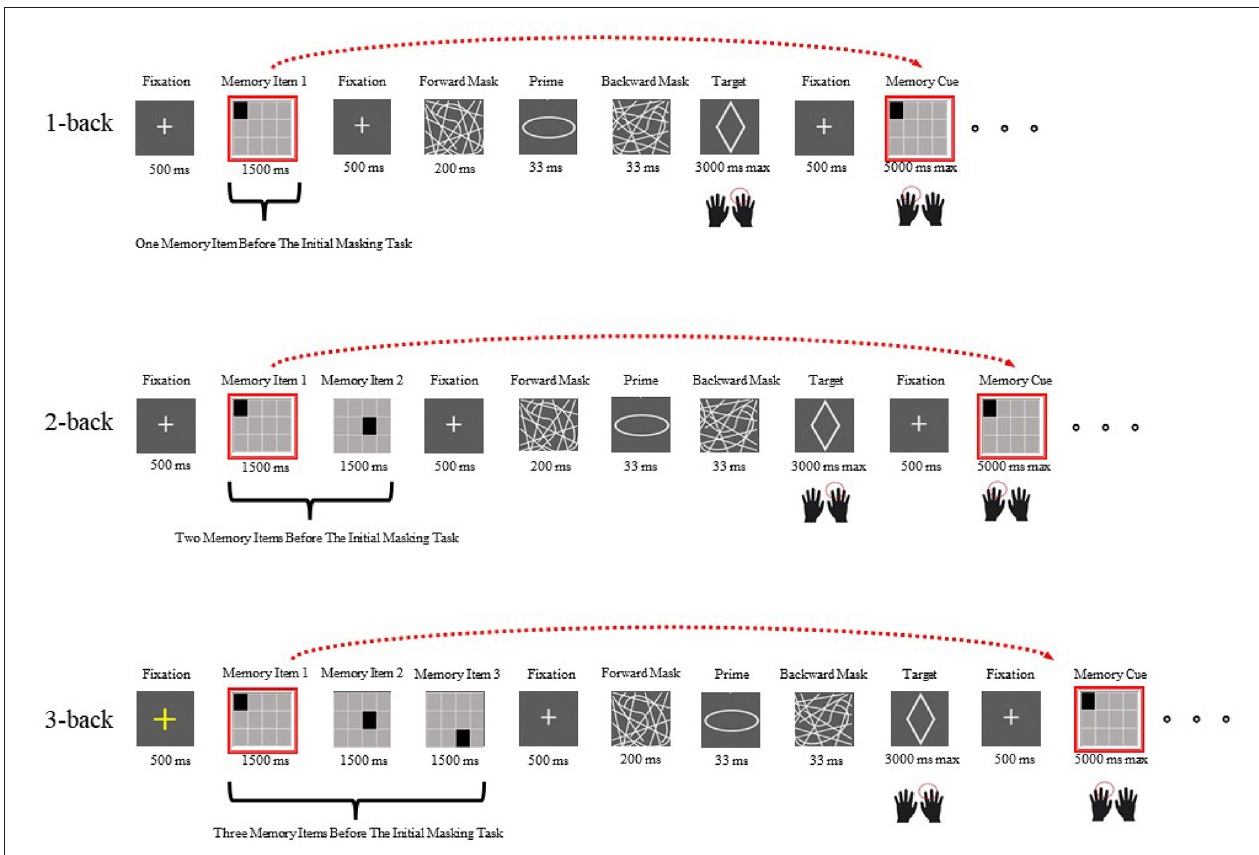
FIGURE 1 | Examples of the first N-back task interleaved with the initial masked visuomotor priming task under each load condition in Experiment 1 (the top row shows the 1-back condition, the middle row shows the 2-back condition and the bottom row shows the 3-back condition). The only variation was that in Experiment 2, the memory items were